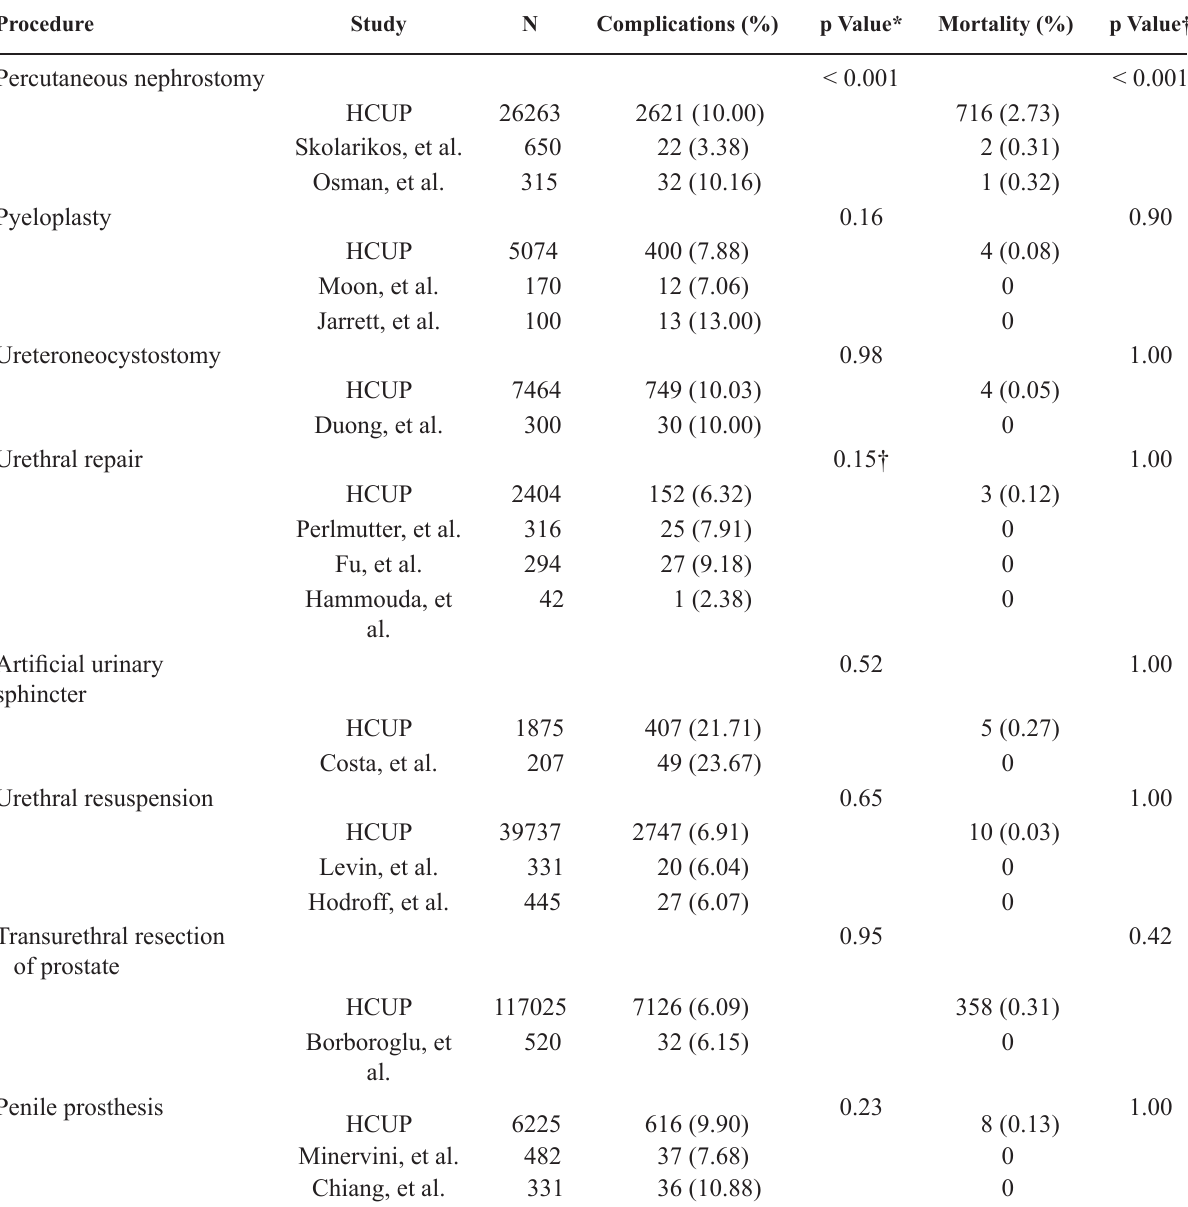
Table 3 – Comparisons of complication rates and mortality rates between HCUP data set and published single-institution case